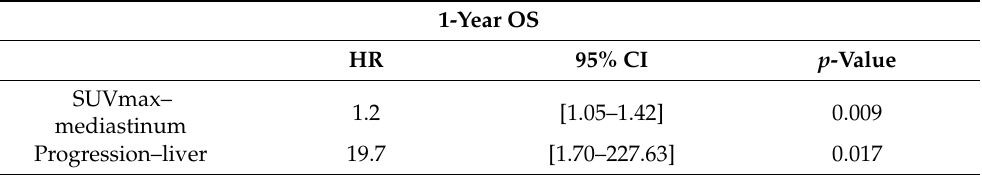
Table 8. Multivariate stepwise Cox analysis of 1-year OS. HR: hazard ratio.